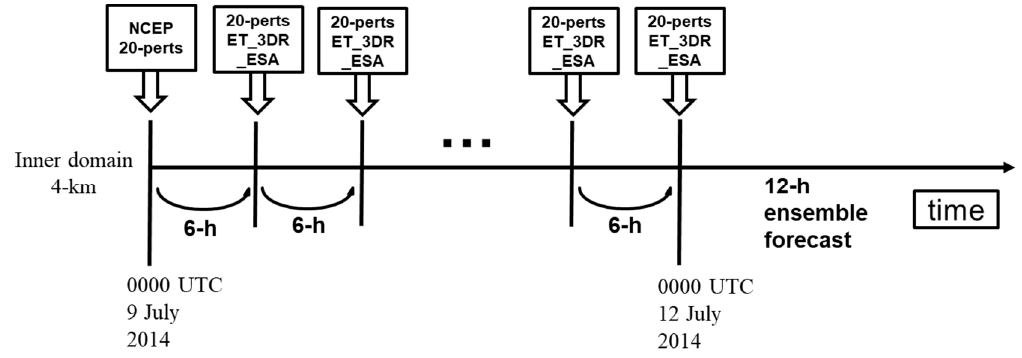
Figure 1. Schematic diagram illustrating the ET_3DR_ESA ensemble forecast system.